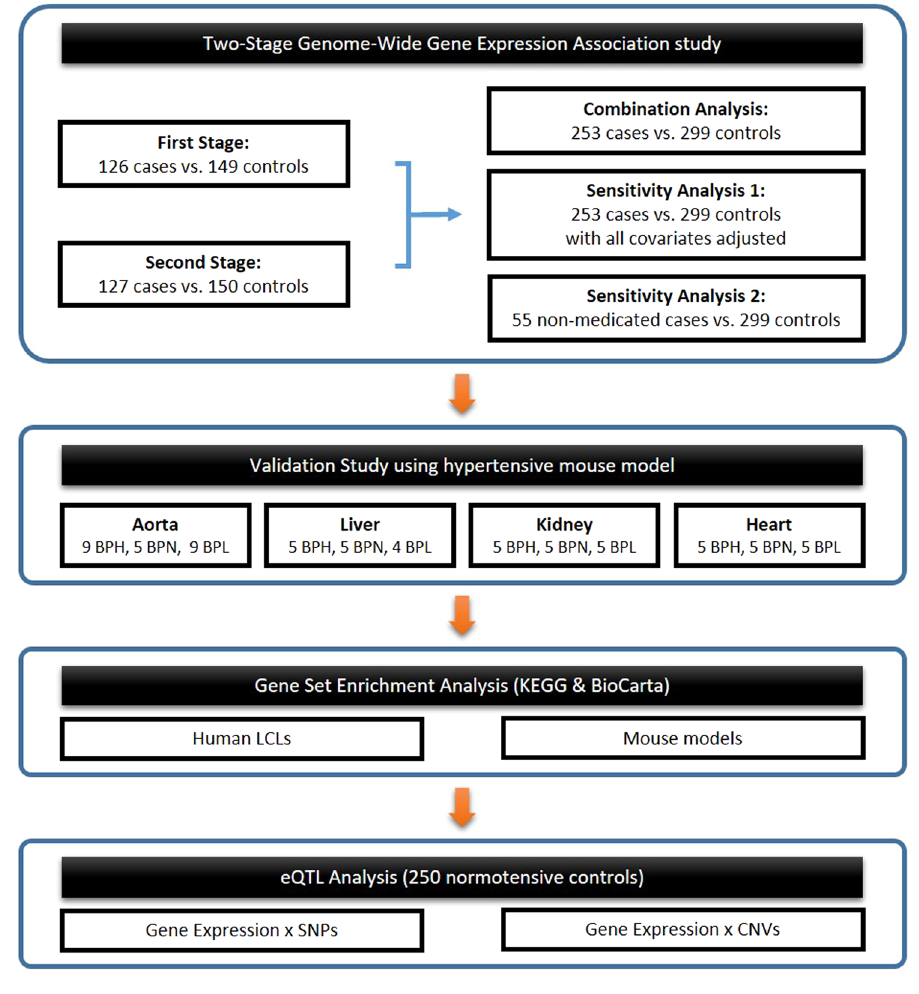
Figure 1. Flow chart of the study design. BPH: high blood pressure, BPL: lowest blood pressure, and BPN: normal blood pressure, LCLs: lymphoblastoid cell lines, eQTL: expression quantitative trait loci, SNP: single nucleotide polymorphism, CNV: copy number